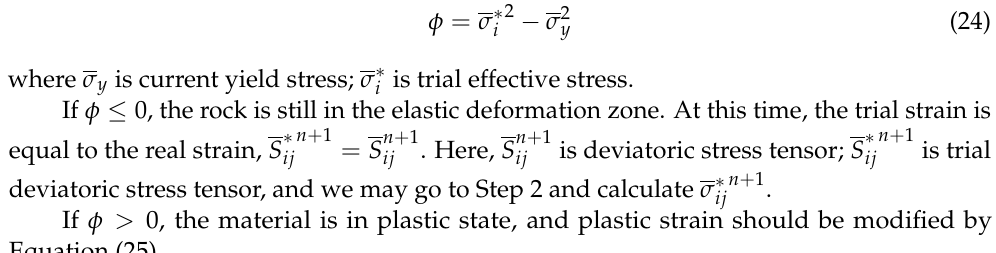
is tension damage degree rock micro-body (0 <